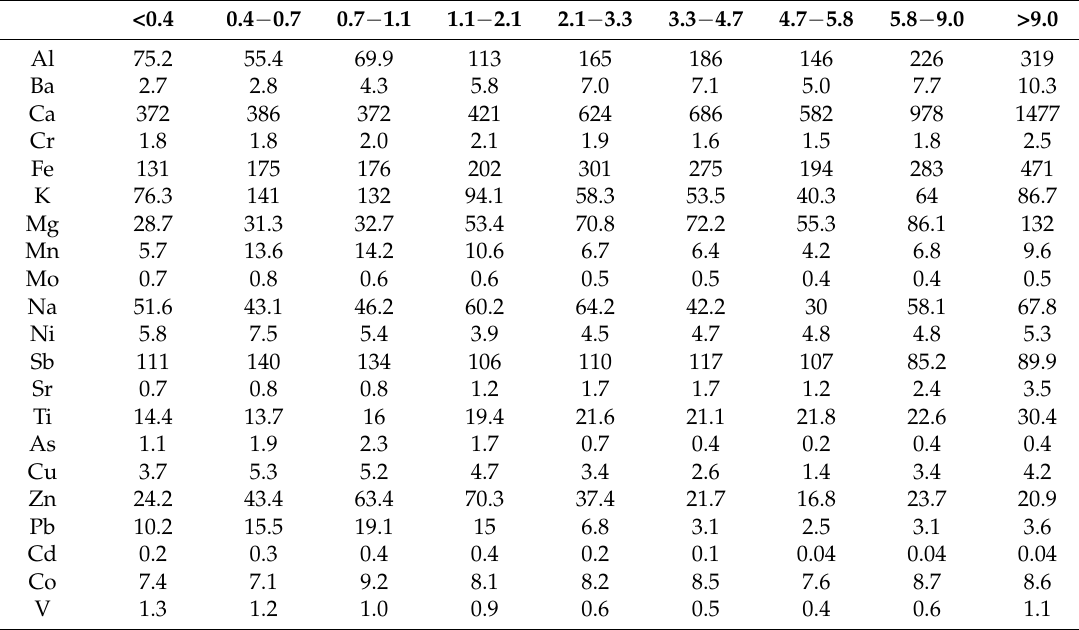
Table 1. Average concentrations (ng m − 3 ) of elements in SSAs ( n = 20).